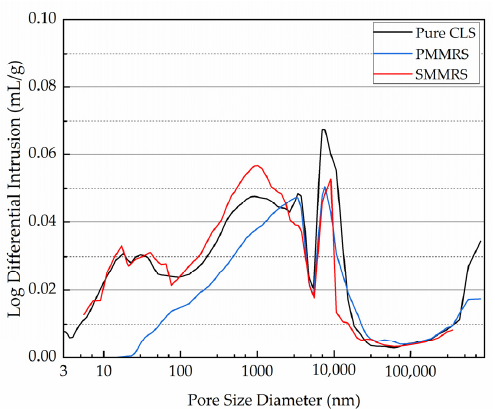
Figure 14. The pore distribution and volume of PMMRS, SMMRS and pure CLS.